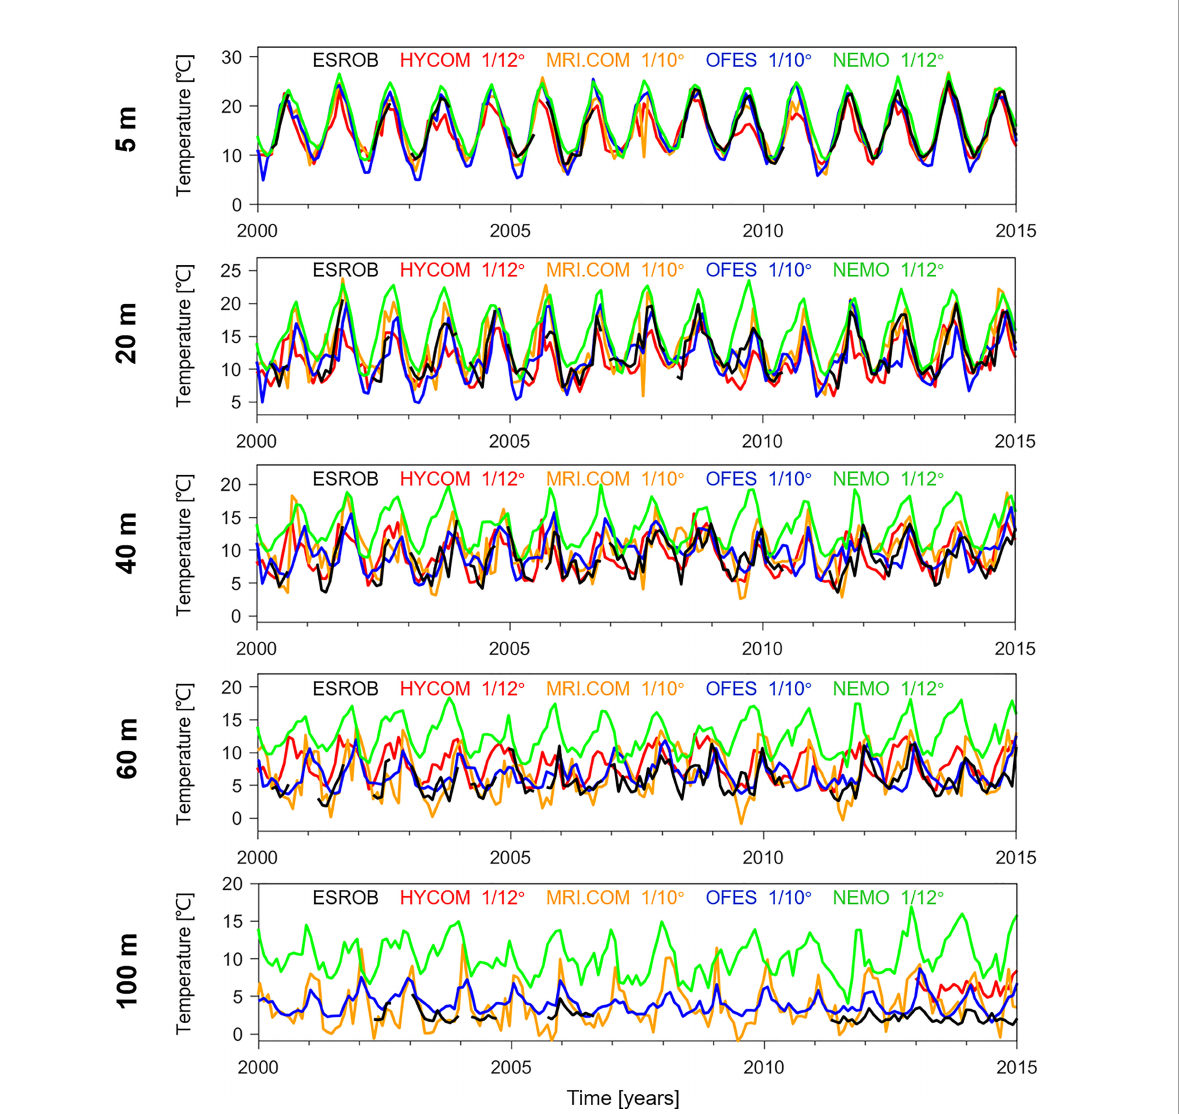
FIGURE 5 Monthly mean temperature from ESROB observation data (black) and the ocean models HYCOM (red), MRI.COM (orange), NEMO (green), and OFES (blue) at 5, 20, 40, 60, and 100 m depths for the time period from 2000 to